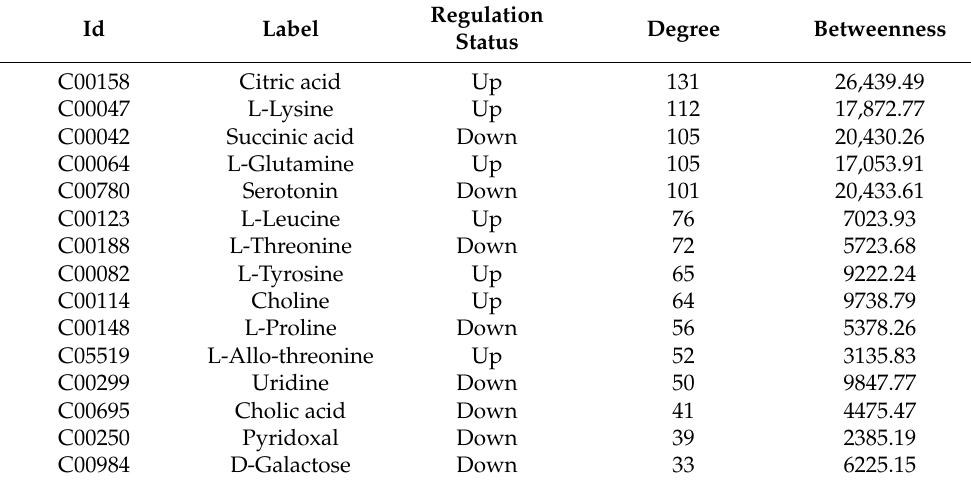
Figure 8. Integrated network illustration of differential metabolites based on the KEGG database. Circular nodes represent different metabolites at different degrees of interaction made through lines connecting and originating them. Central important metabolites in the network are labeled. Table 5. Major diseases and their directly associated metabolites and genes are listed. “Degree” denotes the number of direct connections between nodes, and “Betweenness” shows the centrality of the given interaction. The list of interaction network nodes is given against each corresponding disease along with its regulation status in the heat-stressed granulosa